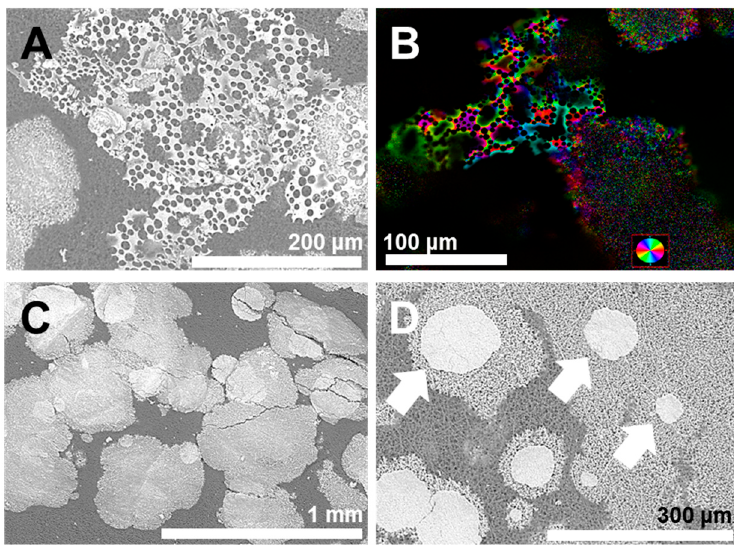
Figure 9. Representative SEM images of mineralized ( A ) outer and ( C , D ) inner surfaces of egg shell membranes in the presence of PAA 35000 (50 ppm); ( B ) crystallographic domains from quantitative polarization mapping (Abrio©, CRi, Woburn, MA, USA) of the mineral structure corresponding to ( A ).